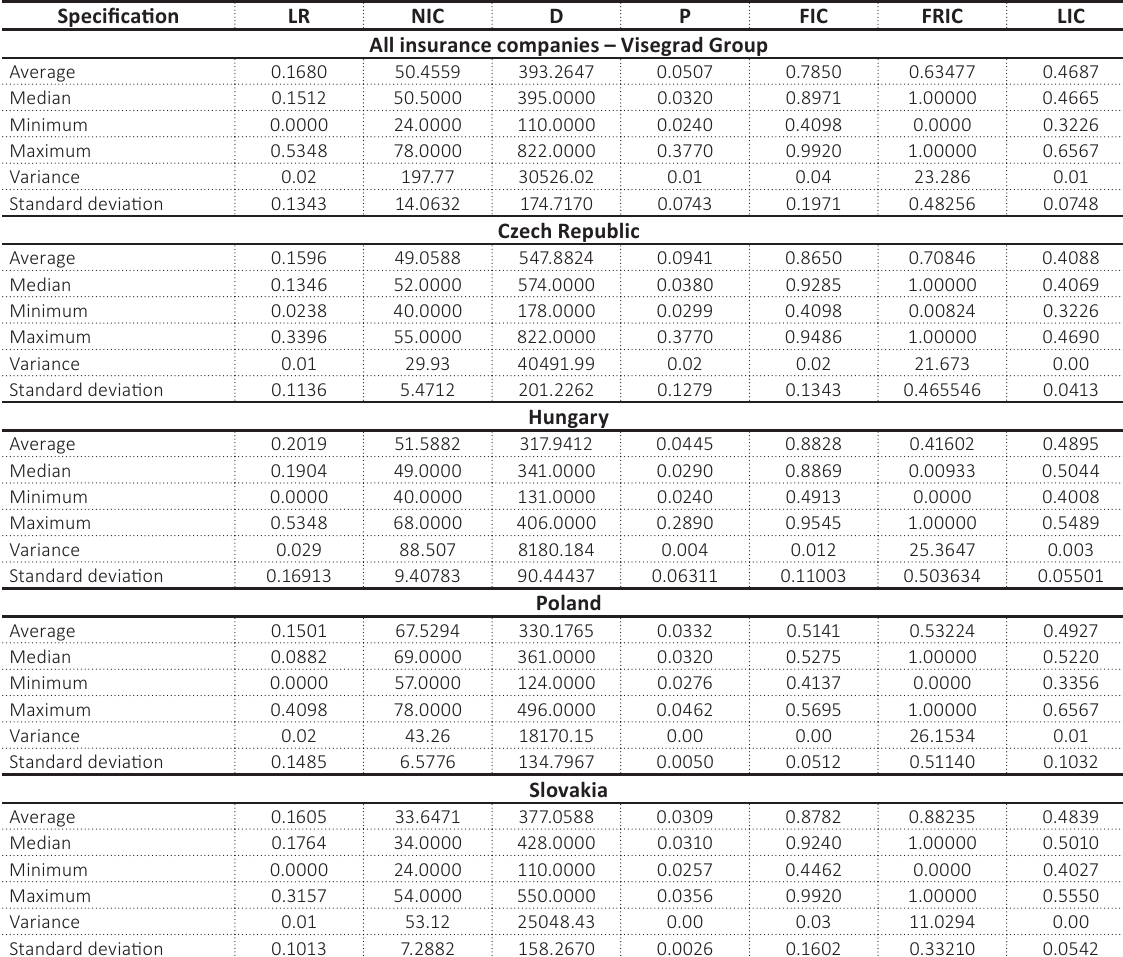
Table 1. Basic statistics outlining the studied variables from the Visegrad Group countries in 2000–2016